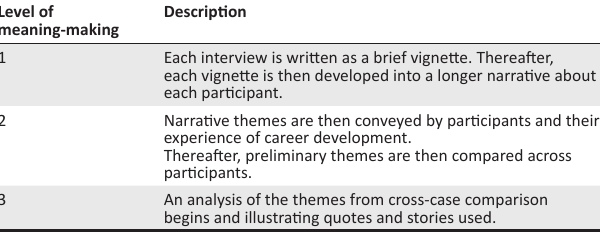
TABLE 3: Data analysis